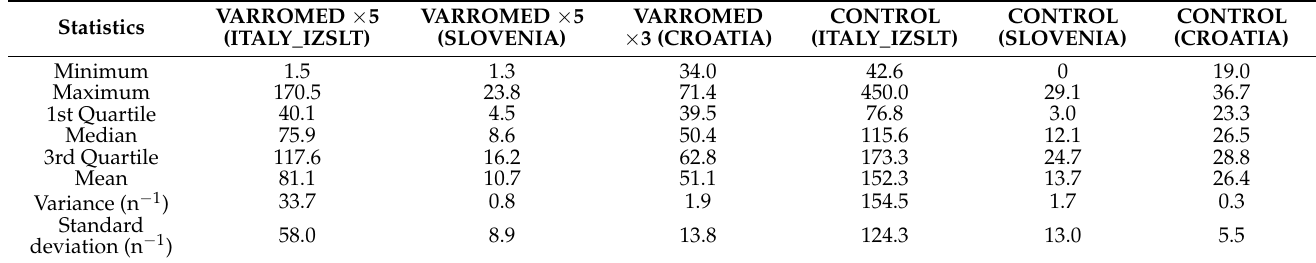
Table 4. Variation of brood area in all groups recorded during the summer/autumn trial compared to the beginning of the treatment (%).